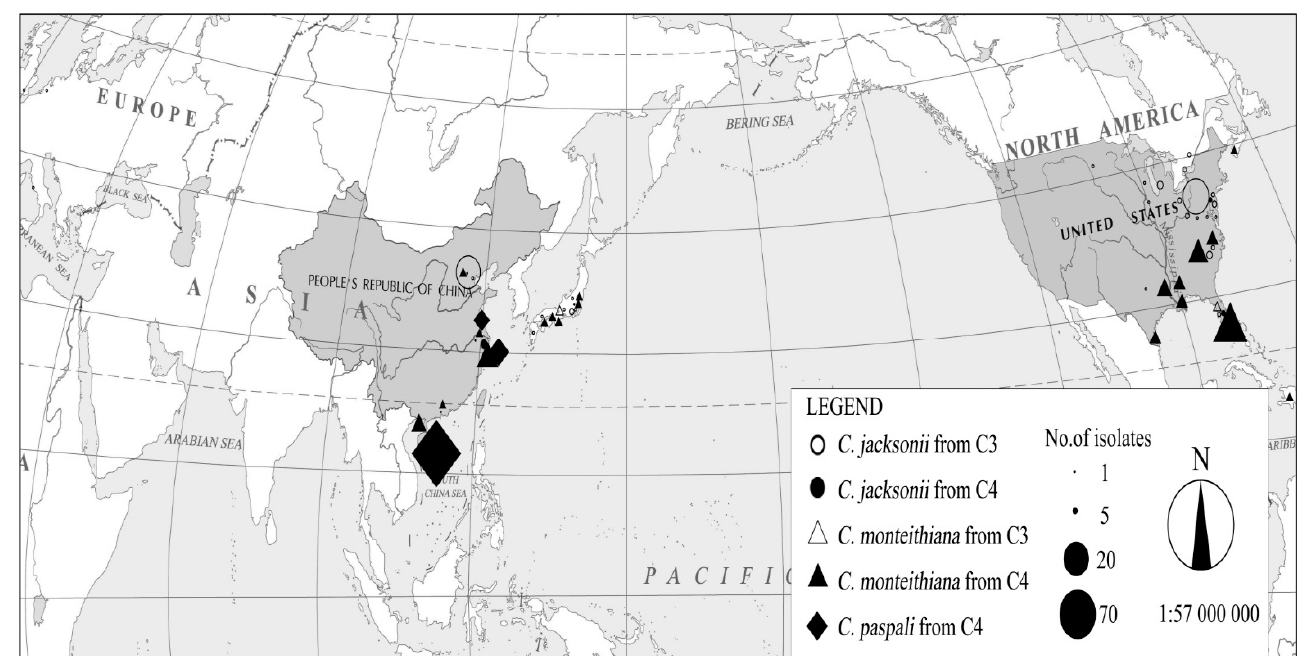
Figure 1. Global distributions of different Clarireedia species.